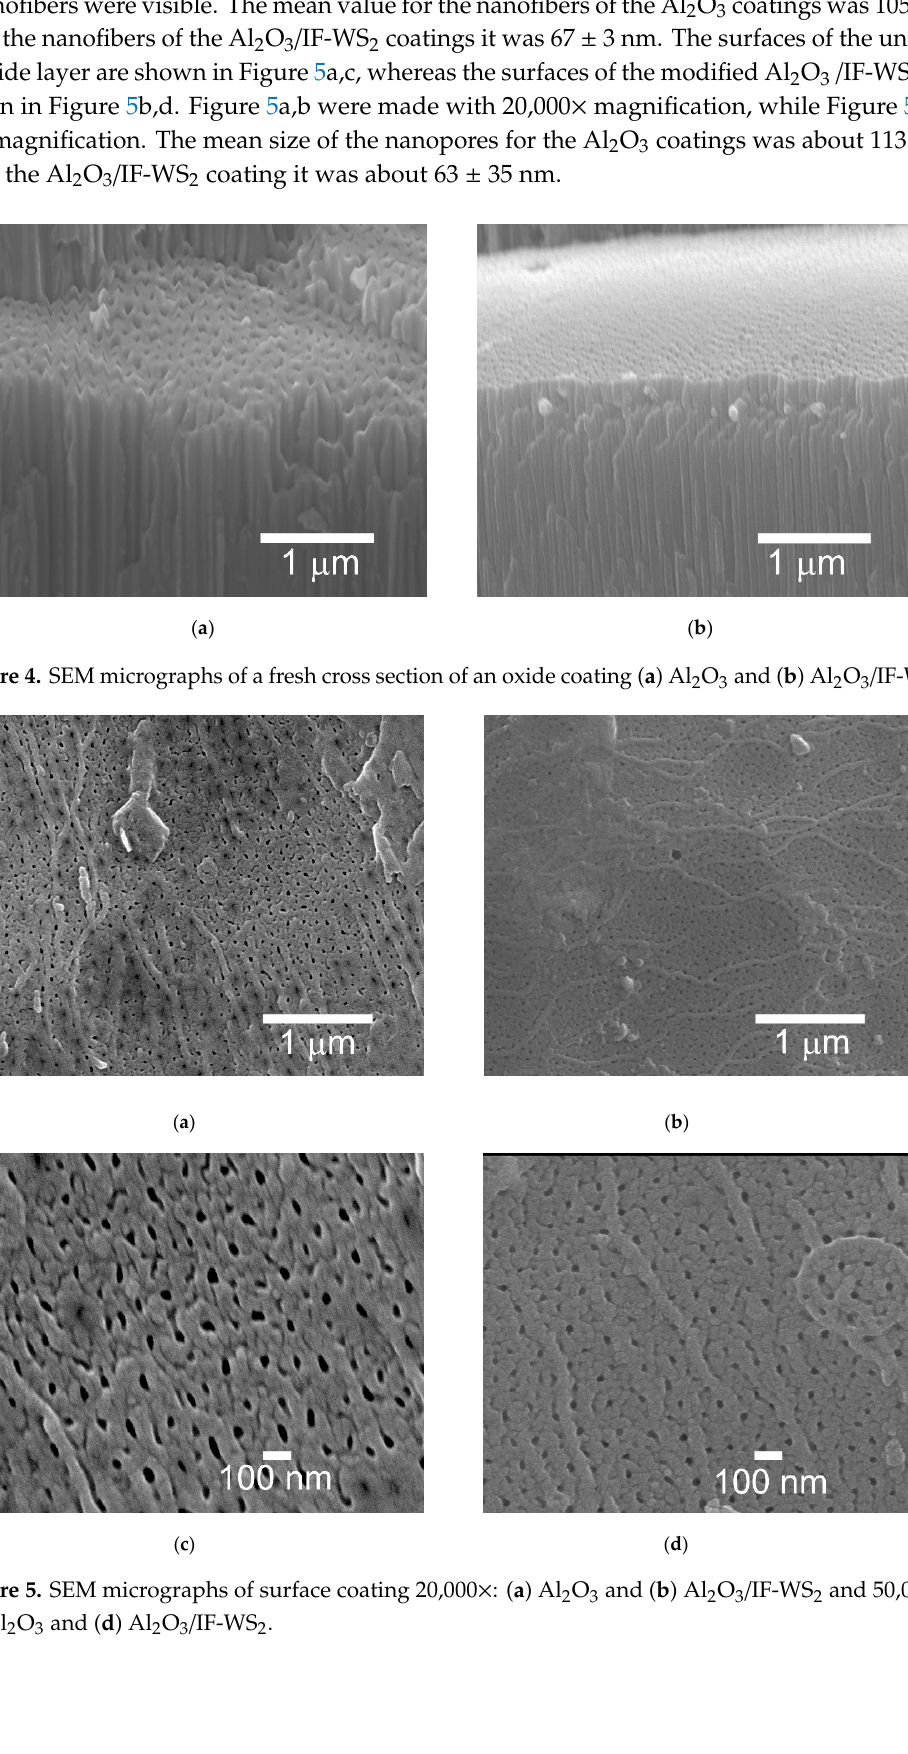
Figure 5. SEM micrographs of surface coating 20,000 × : ( a ) Al 2 O 3 and ( b ) Al 2 O 3 / IF-WS 2 and 50,000 × : ( c ) Al 2 O 3 and ( d ) Al 2 O 3 / IF-WS 2